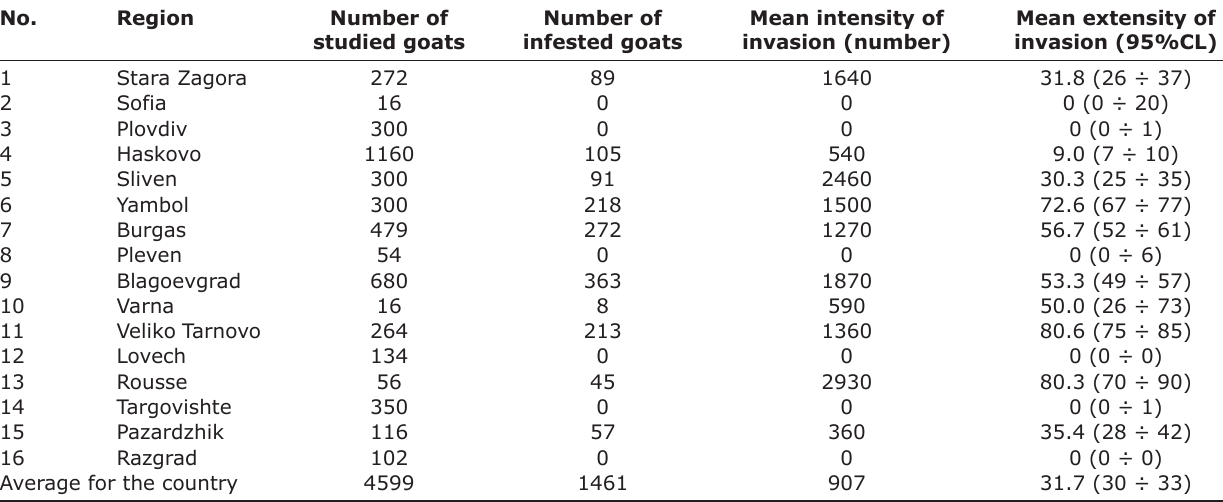
Average for the country